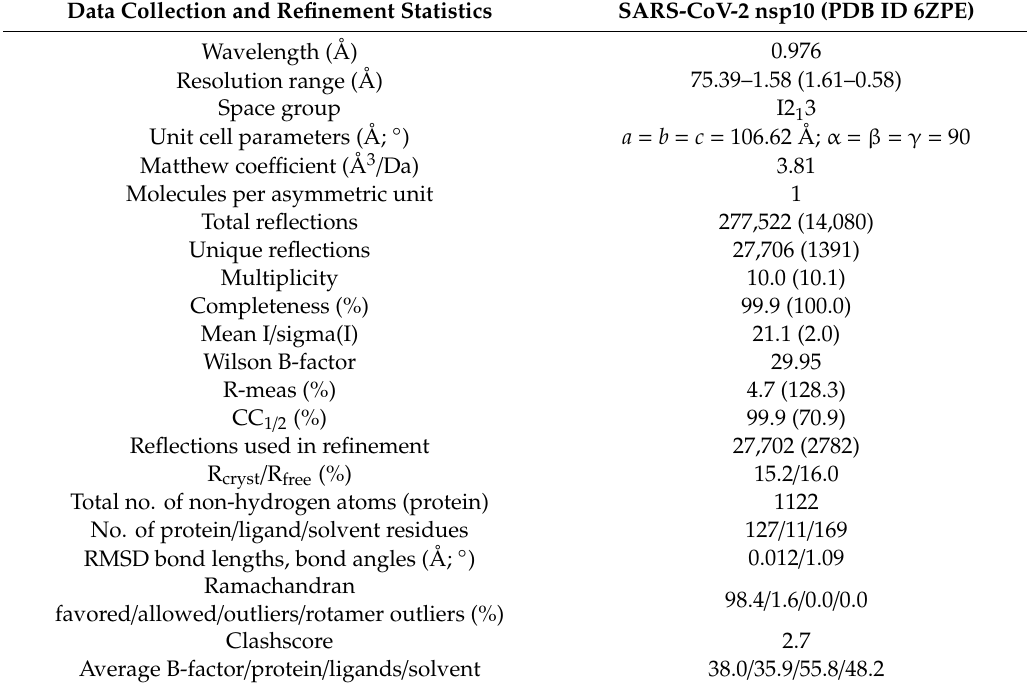
Table 1. Data collection, structure determination and refinement statistics for nsp10 from SARS-CoV-2. Data in parenthesis correspond to the highest resolution